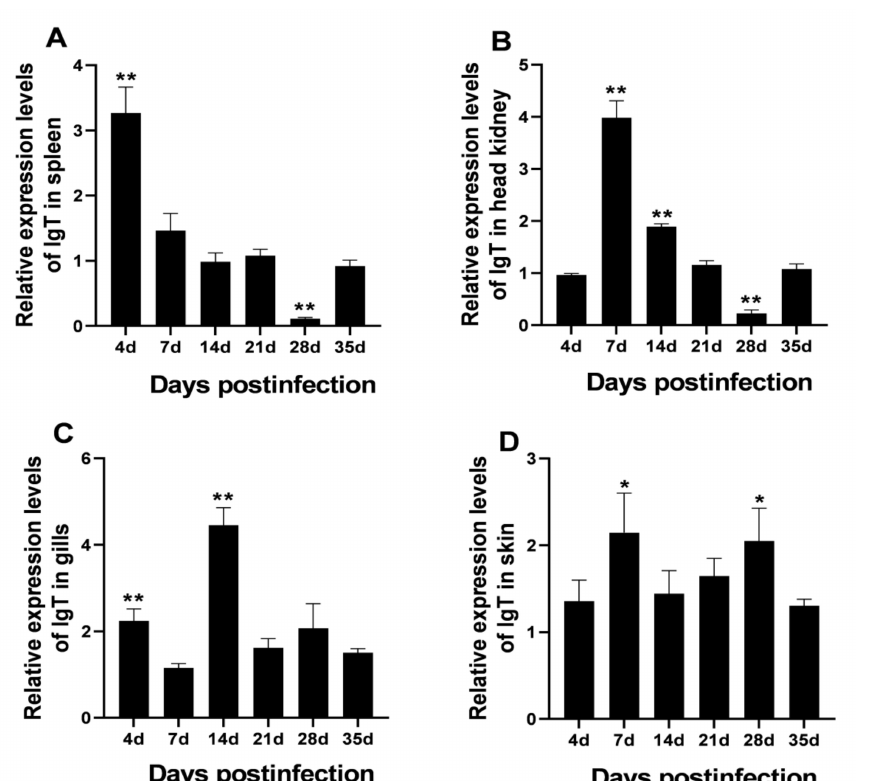
Figure 5. Expression modulation of Lc IgT in large yellow croakers infected by C. irritans . Expression change of Lc IgT mRNA upon C. irritans infection was analyzed by real-time PCR. Four tissues, spleen ( A ), head kidney ( B ), gills ( C ), and skin ( D ), were collected from five C. irritans -infected fish or